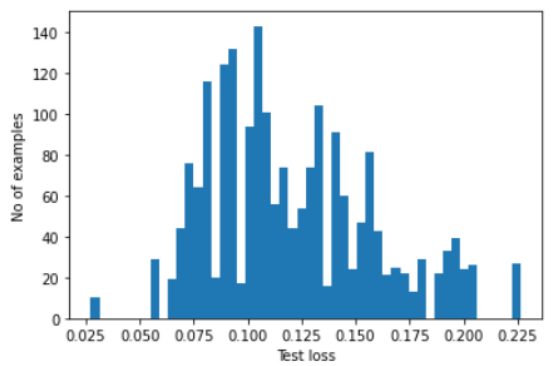
Figure 16. Histogram of test